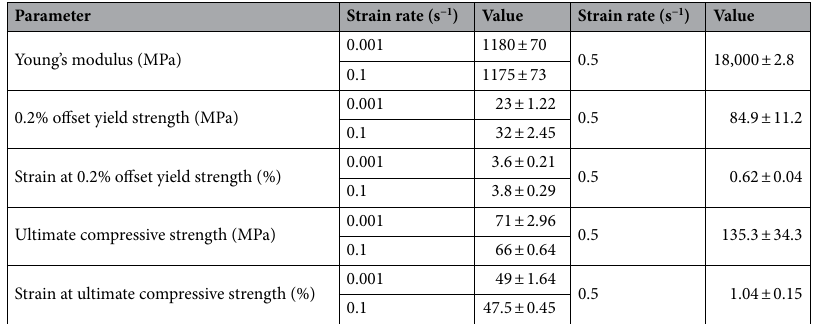
Table 2. Biomechanical properties of polyurethane-based foam material in a composite femur model used in the present study compared with adult human femoral bone. MPa megapascal.